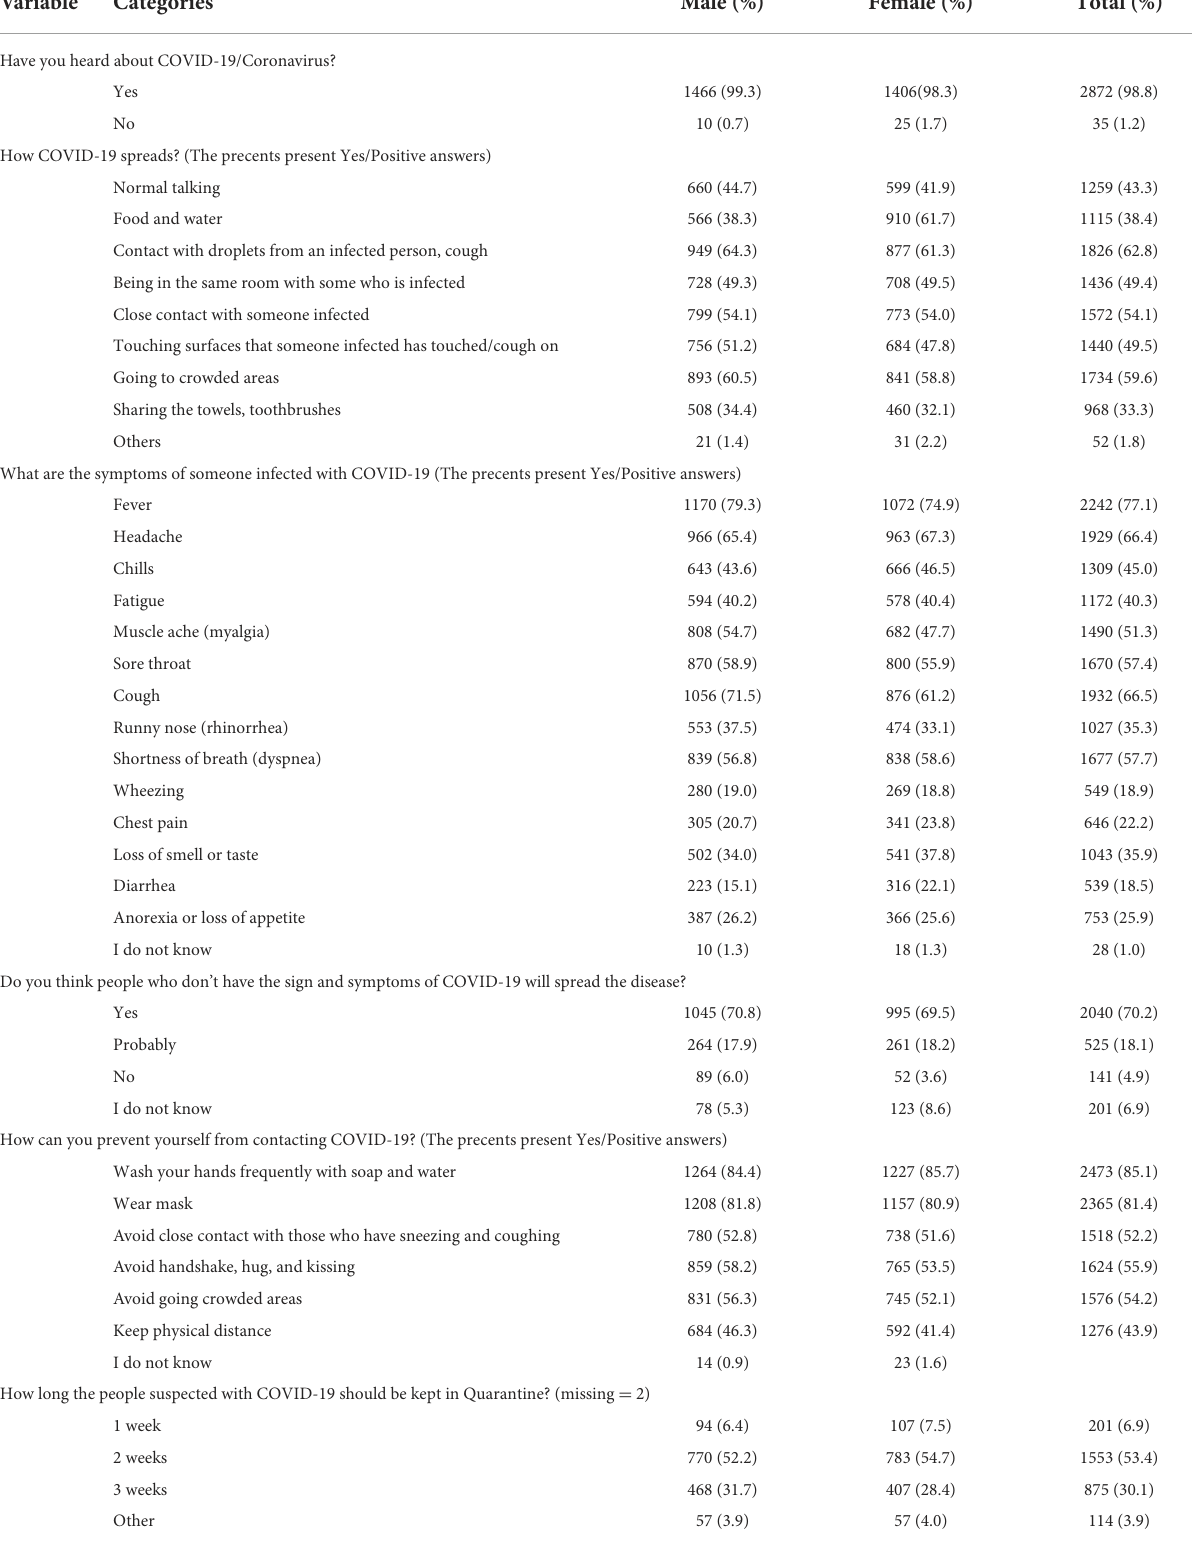
TABLE 2 Frequency distribution on knowledge of participant ( N =